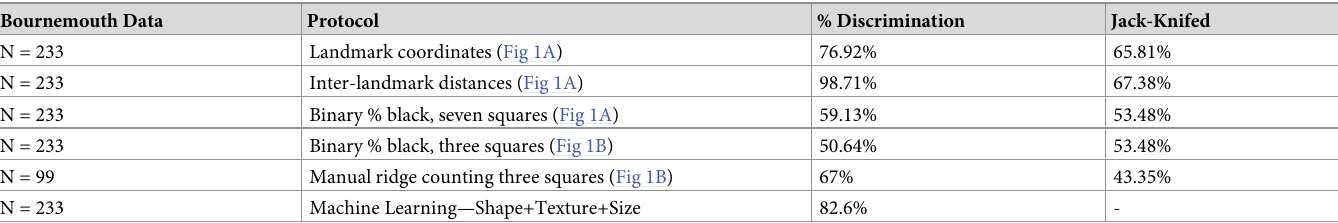
Table 1. Sex discrimination on the Bournemouth data using various methods.